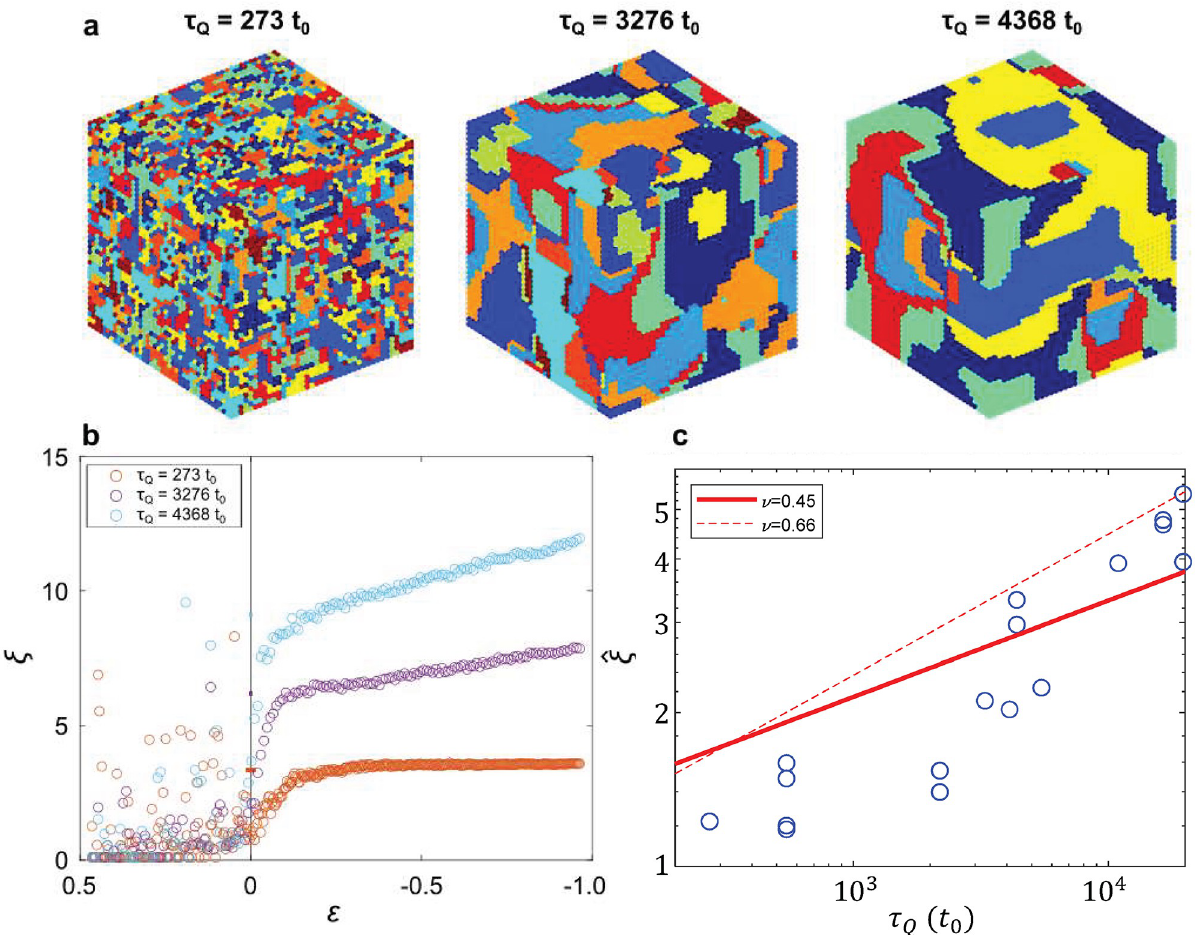
Fig 5. Comparison to KZM predictions. (a) Final simulation state at T = D 0 , following a quench at three τ As τ increases, larger domain size, lower concentration of defects, and larger ^ x can be seen by eye. (b) ξ vs. ε for the three simulation runs shown in Q (a), extracted by fitting to C 7 ( r ). (c) Values of ^ x (blue points) extracted from simulation runs with different τ Q , compared to the prediction of the KZM (red).